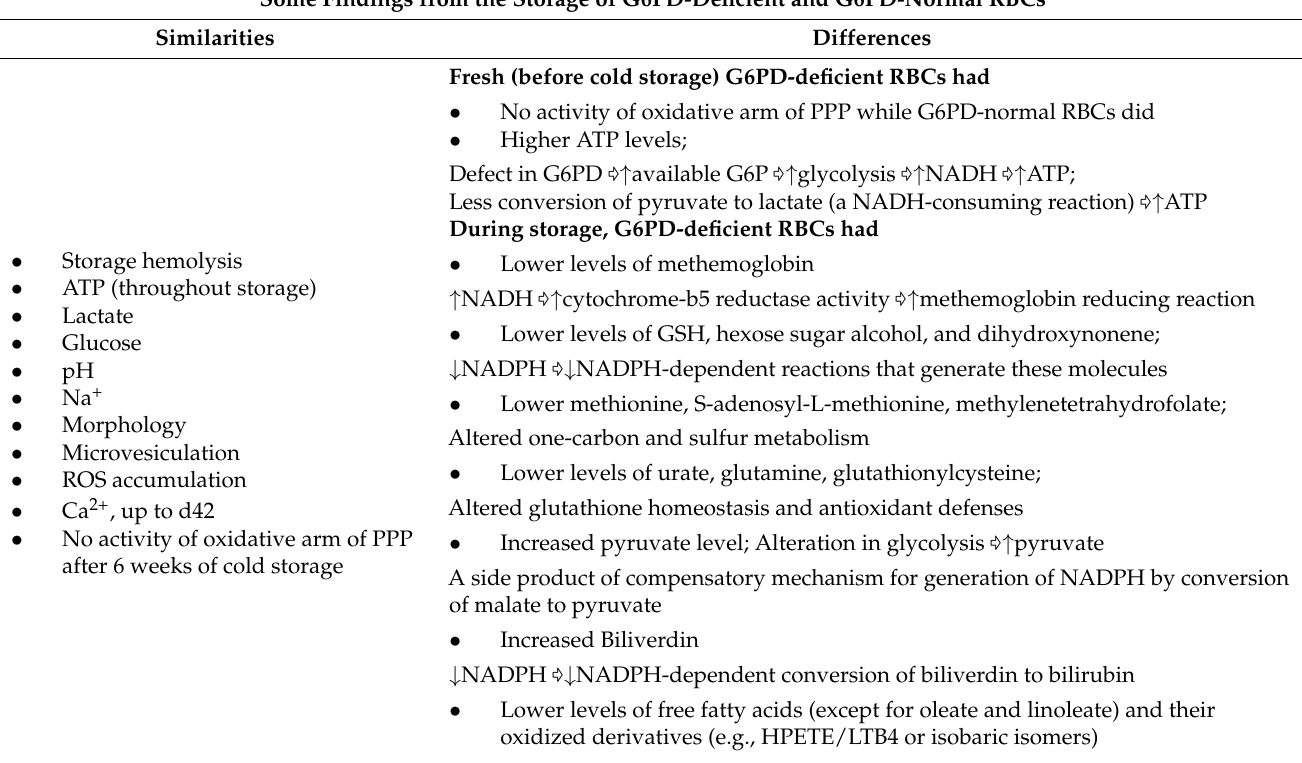
Table 1. Some of the similarities and differences between G6PD-deficient and G6PD-normal RBCs during blood bank storage